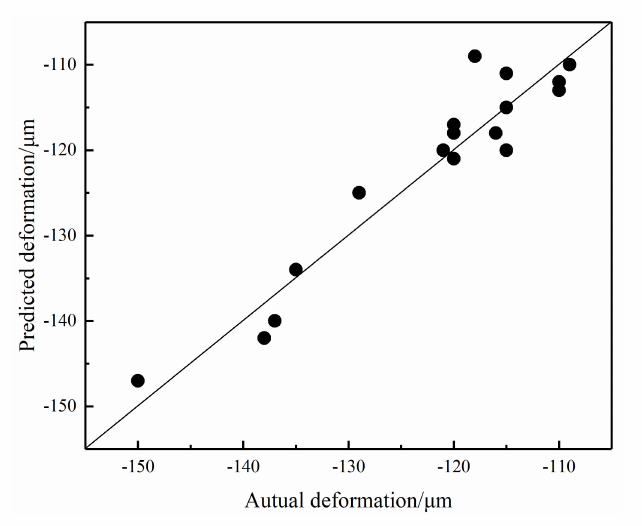
Figure 7. Scatter plot between the actual and predicted deformation.